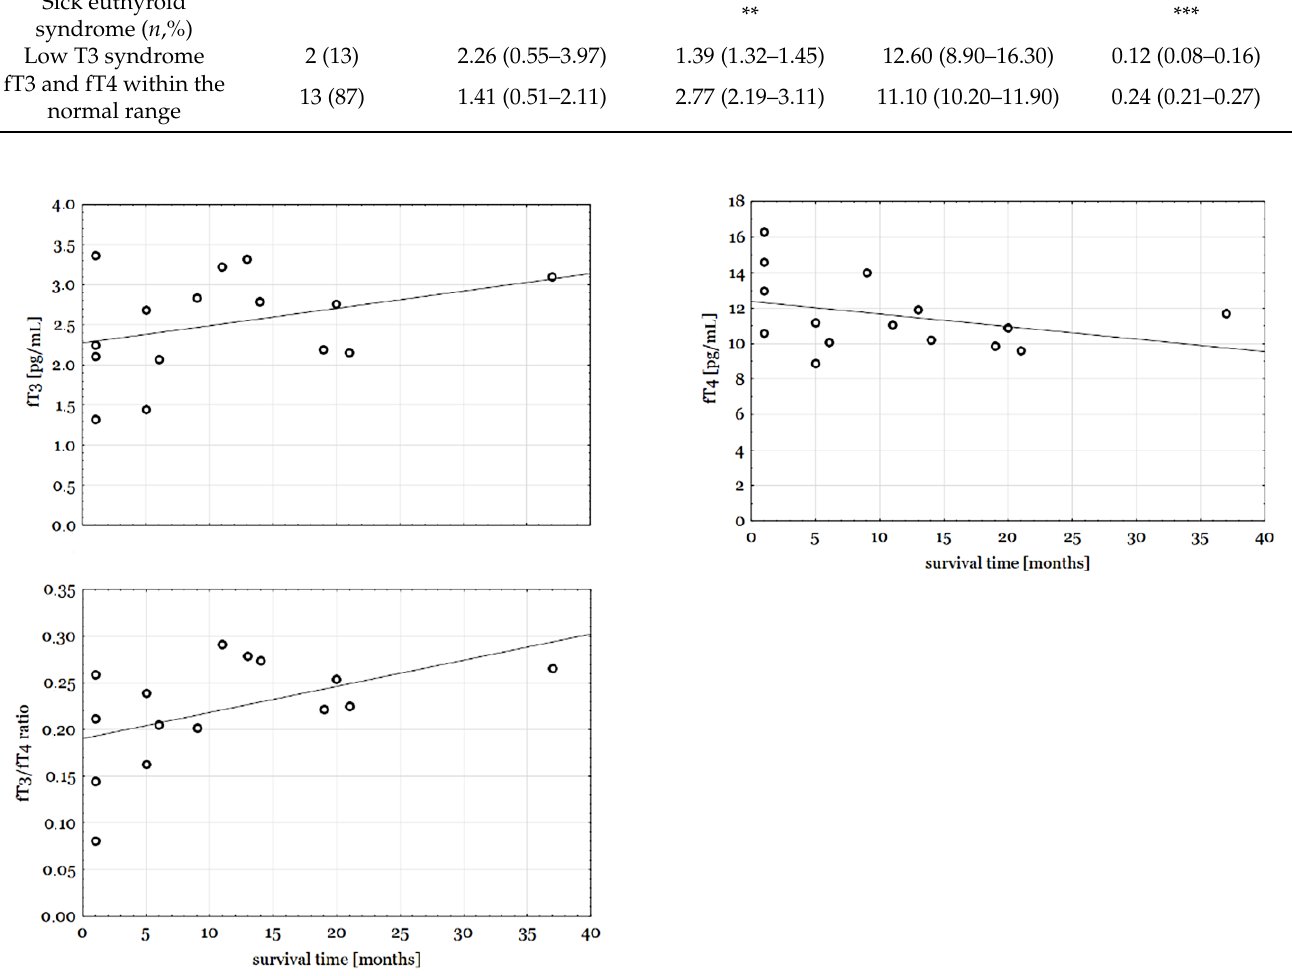
Figure 1. – fT3, fT4 concentrations and fT3/fT4 ratio vs. overall survival. Figure 1. fT3, fT4 concentrations and fT3/fT4 ratio vs. overall